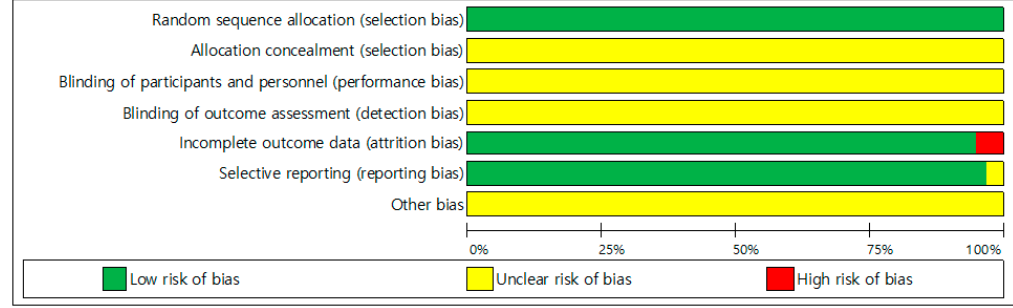
Figure 2. Assessment of risk of bias in included studies.